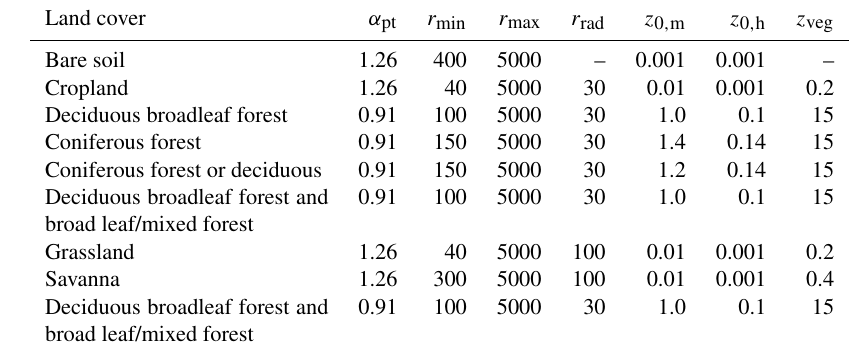
Table B1. Land cover specific parameters.